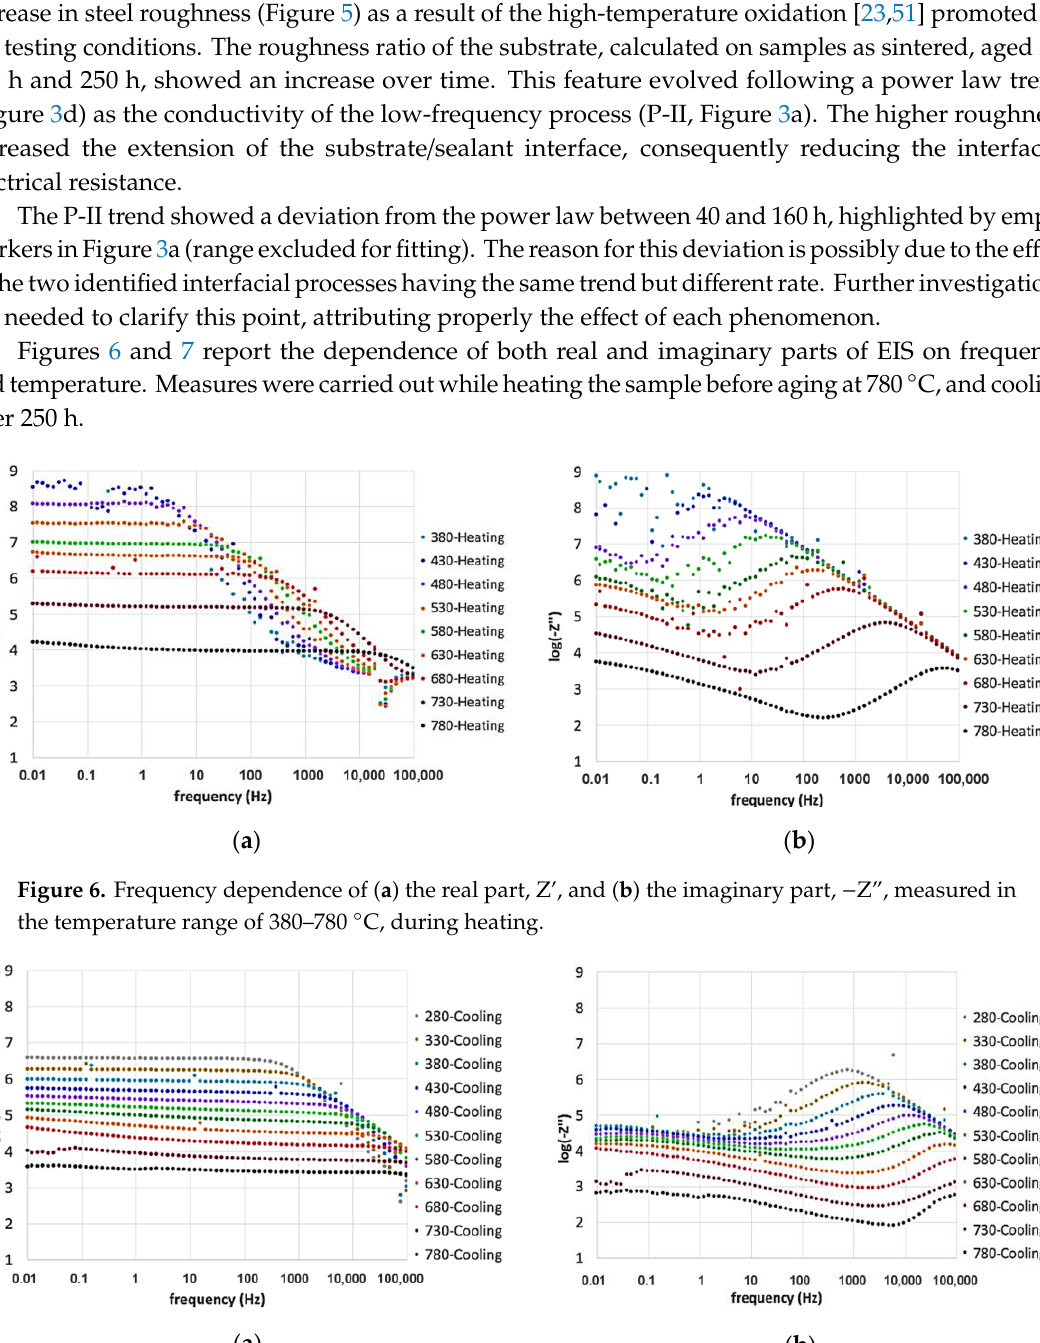
8 of 13 Figure 5. SEM-BSE cross-section image and EDX line scans of the sample ( a ) before aging and ( b ) aged for 250 h at 780 °C. From the morphological point of view, the substrate/sealant interface evolved over time, showing an increase in steel roughness (Figure 5) as a result of the high-temperature oxidation [23,51] promoted by the testing conditions. The roughness ratio of the substrate, calculated on samples as sintered, aged for 100 h and 250 h, showed an increase over time. This feature evolved following a